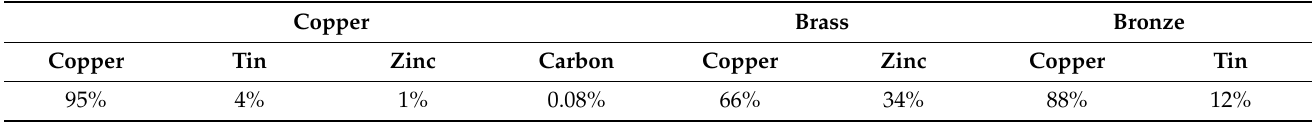
Table 2. Chemical composition of the electrode.